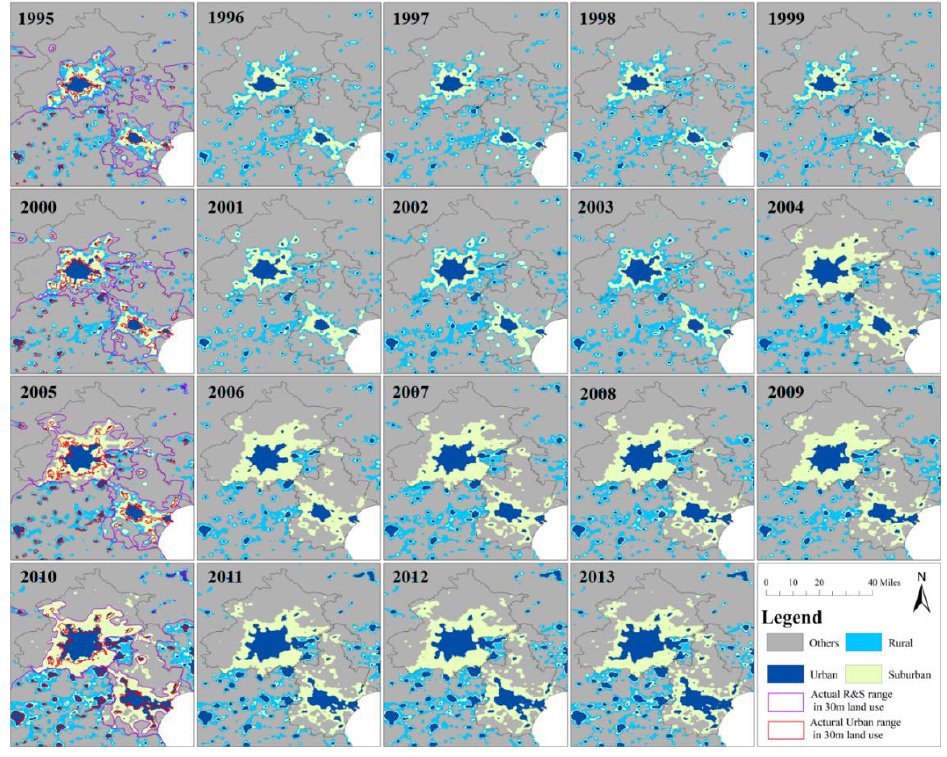
Figure 6. USR change in JJJ from 1995 to 2013.